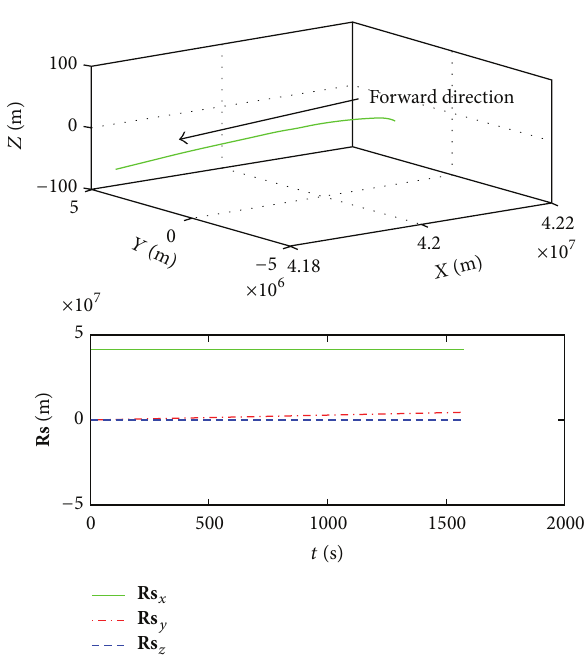
Figure 8: The trajectory of the abandoned